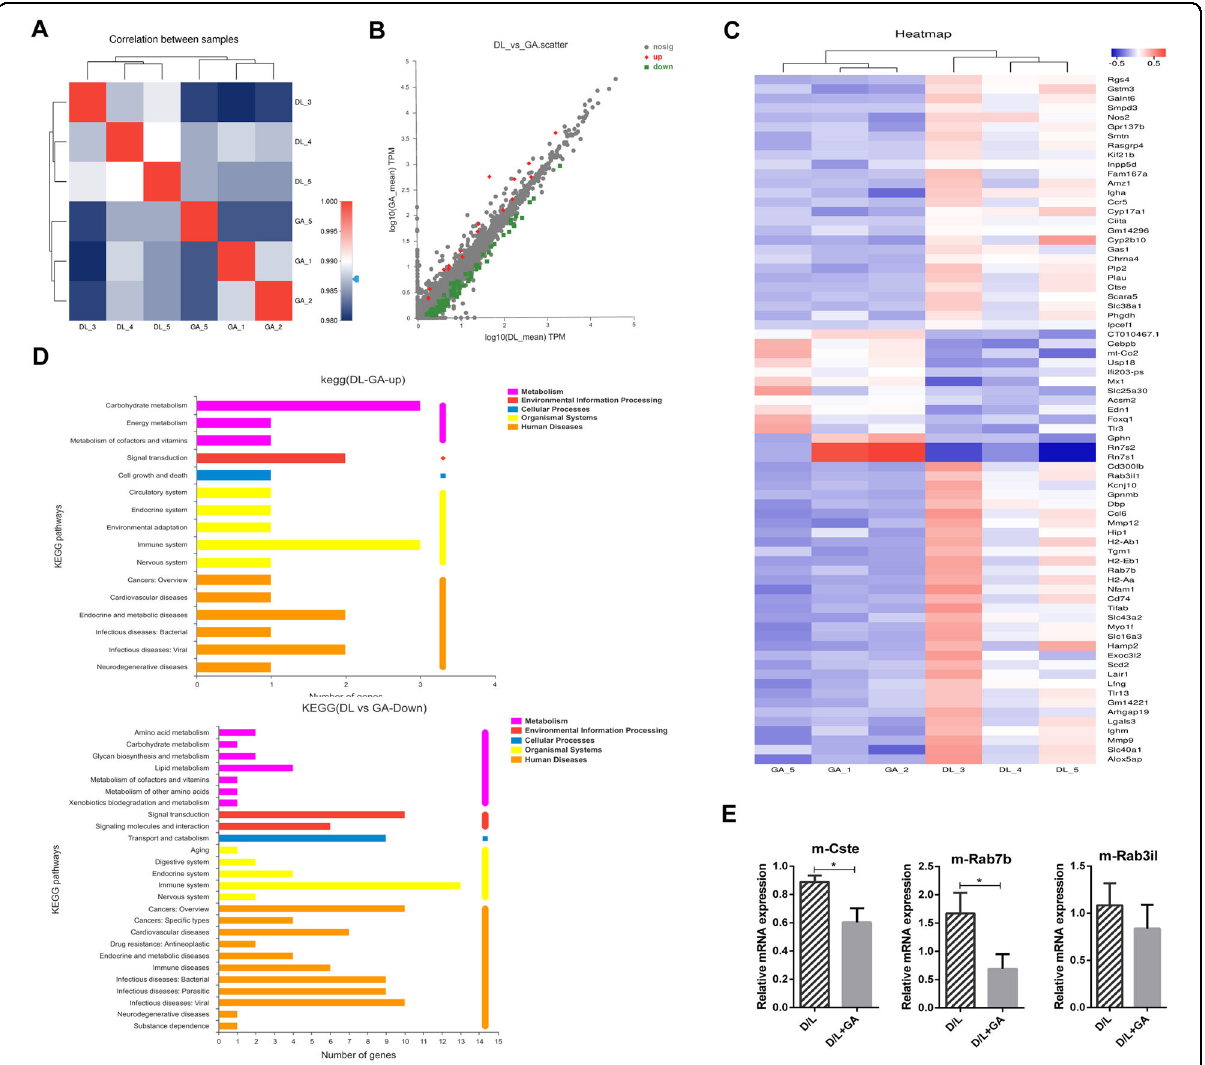
Fig. 4 RNA-seq analysis of liver tissues from D/L- and/or GA-treated mice. Eight-week-old male mice were treated with or without GA for 5 days, and then treated with 300 mg/kg D-GalN plus 10 μ g/kg LPS for 4 h ( n = 3). Pearson ’ s correlation matrix of liver samples ( A ). Volcano plots ( B ) and Heat map ( C ) were used to depict the differential expression of liver genes. KEGG pathway analysis ( D ). Liver lysates from D/L- and/or GA-treated mice were used for the detection of autophagolysosomal SDEGs (Cst E, Rab7b, and Rab3il) by RT-PCR analysis ( E ). Statistical signi fi cance relative to the D/L group: * P <